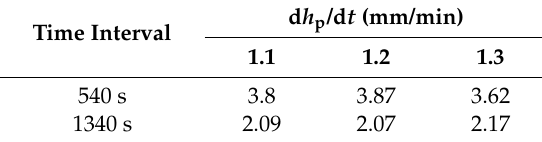
Table 2. Sedimentation and coalescence rates in mm/min obtained by triplicate batch-settling experiments.